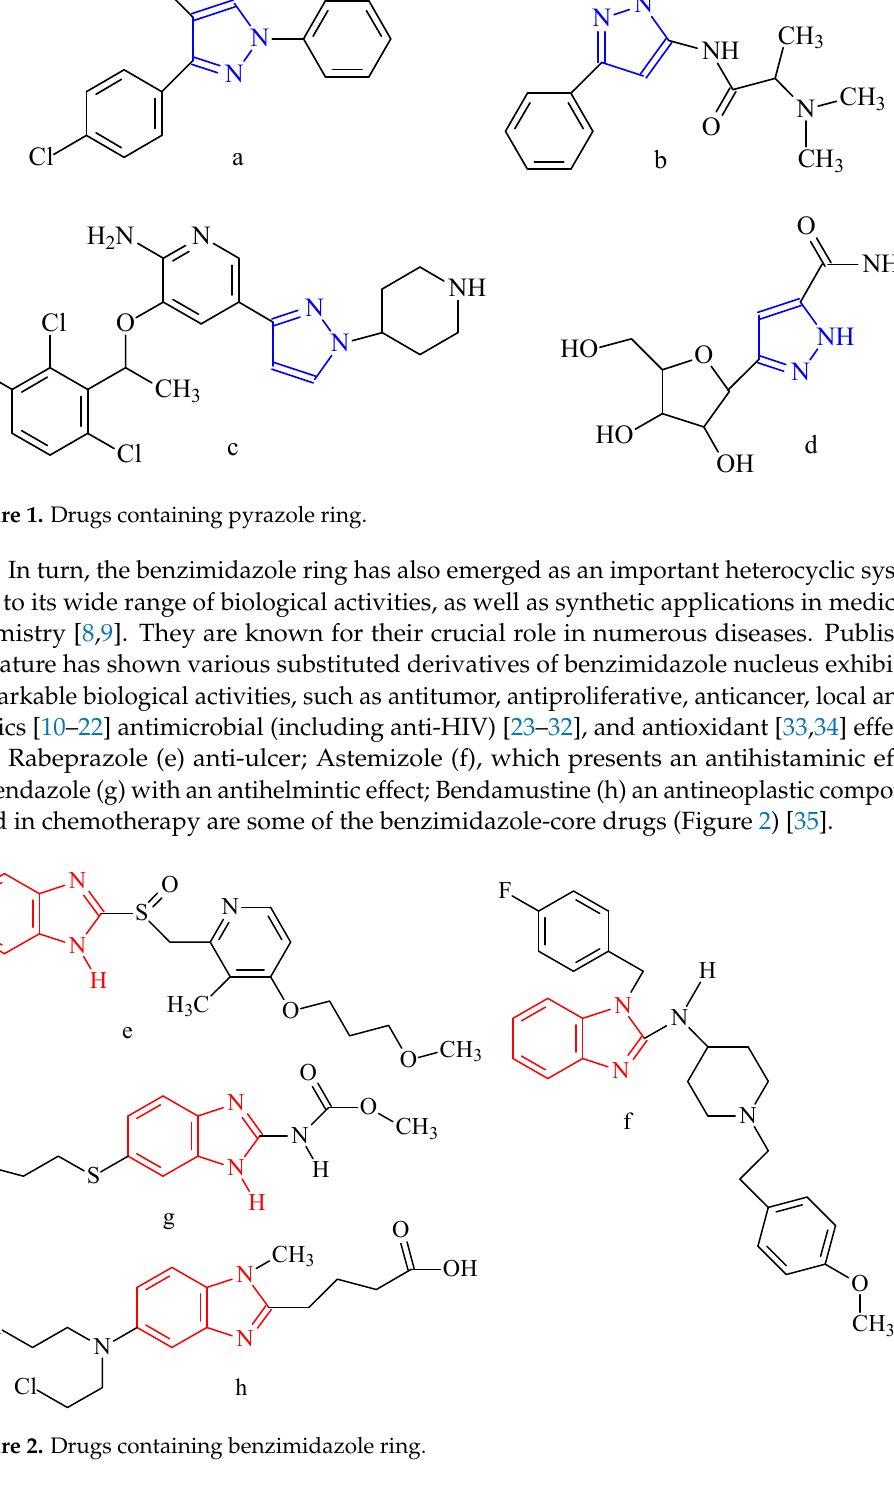
Figure 2. Drugs containing benzimidazole ring.